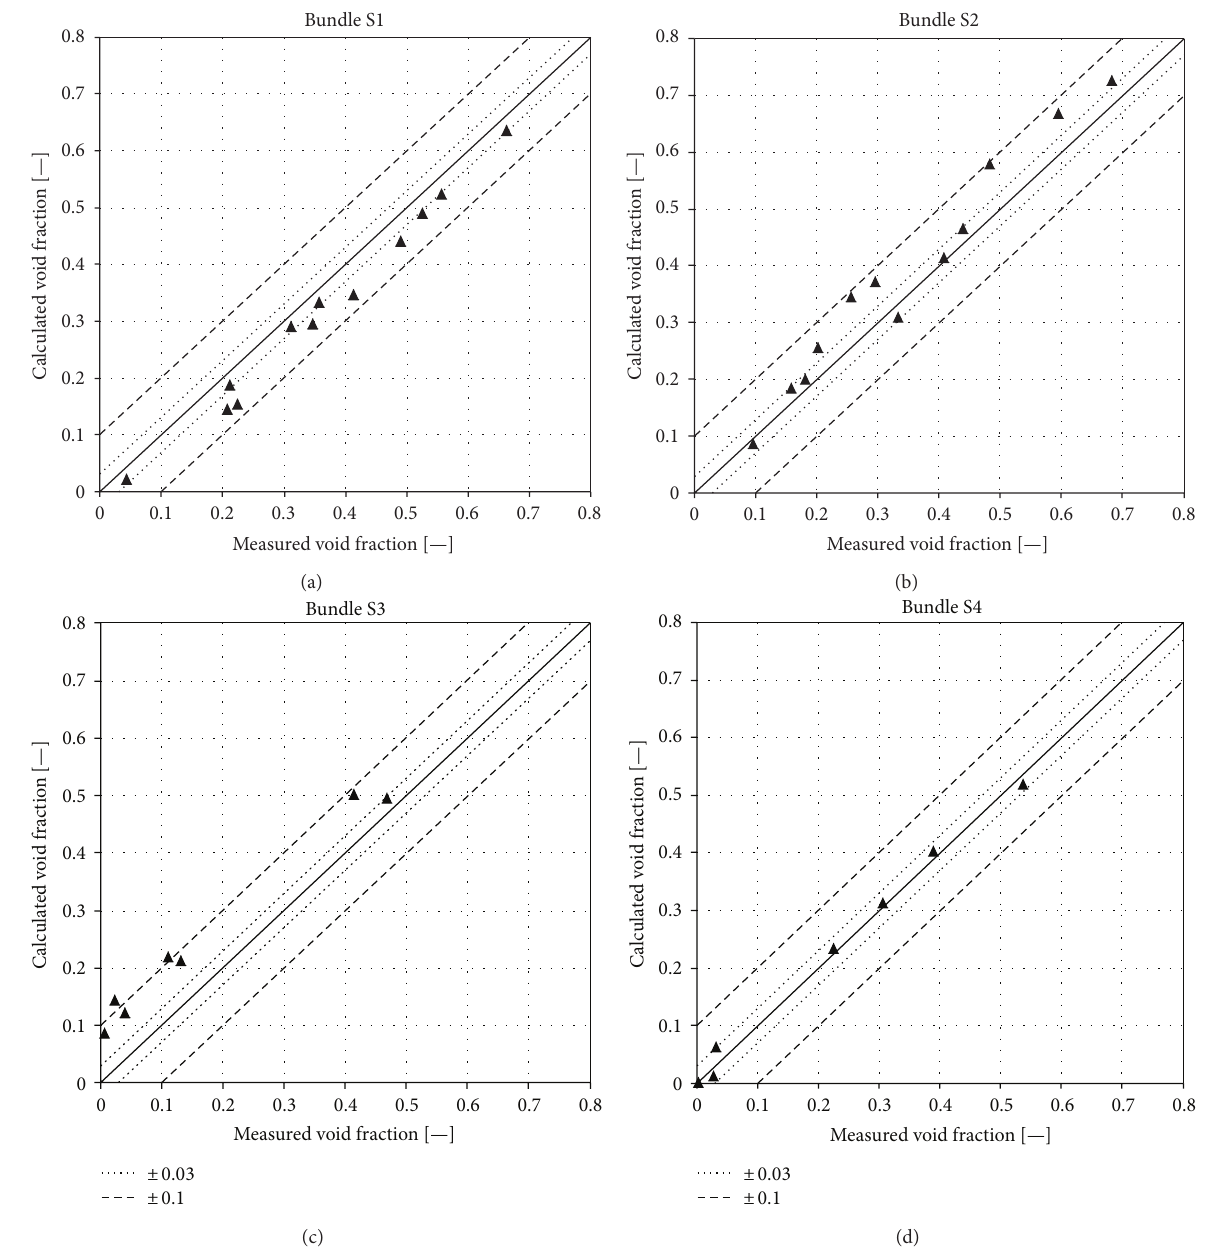
Figure 1: CTF predictions of steady-state void fraction in single-subchannel tests. Table 4: Range of NUPEC PWR test facility operating conditions. Table 5: Transient parameters of NUPEC PWR test